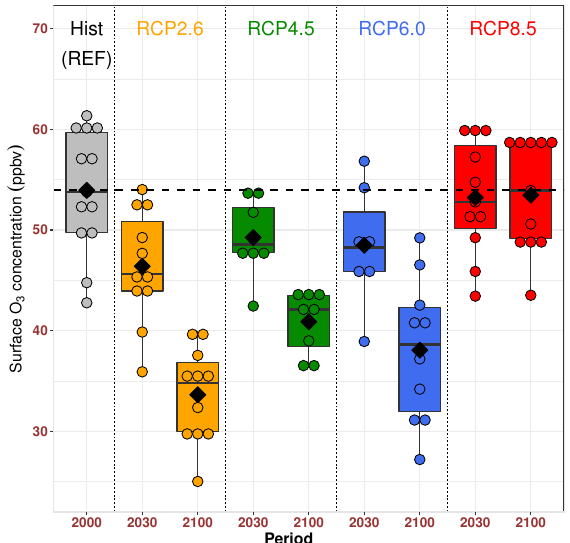
Figure8. SameasFig.6butforthesurfaceozoneconcentrations(ppbv). Figure 8. Same as Fig. 6 but for the surface ozone concentrations